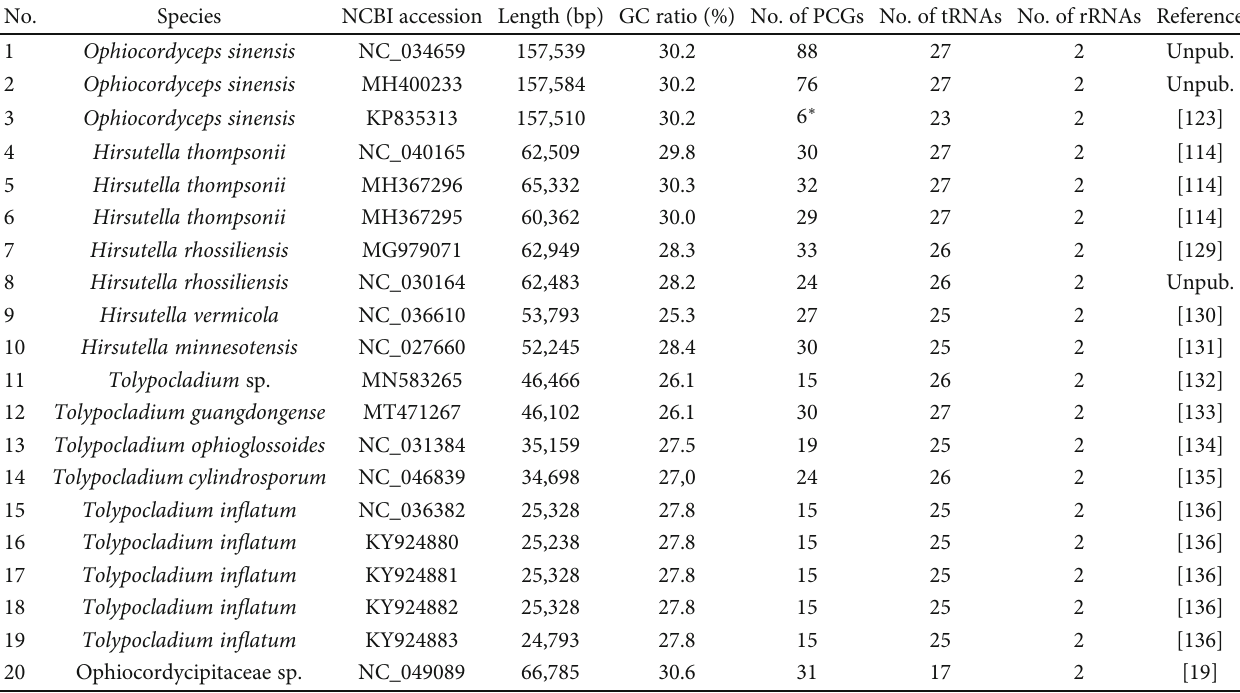
Table 4: List of available complete fungal mitogenomes in Ophiocordycipitaceae.